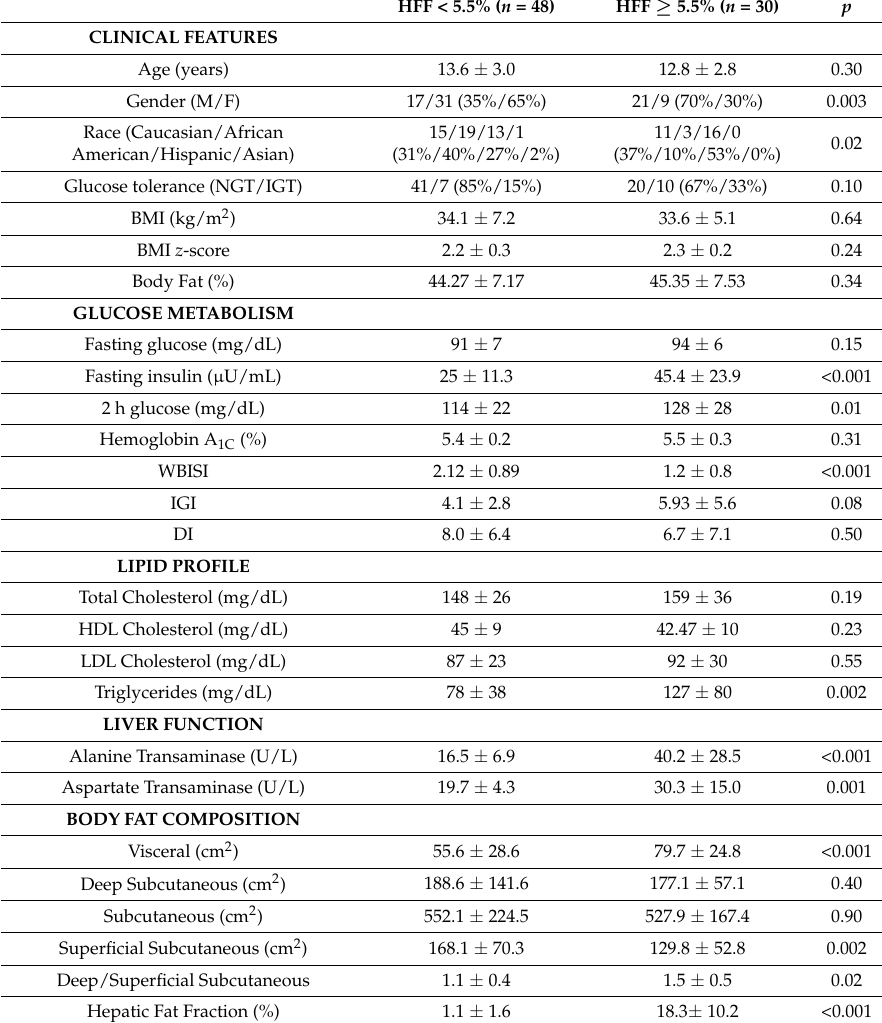
Table 1. Characteristics of the study population stratified by hepatic fat content (HFF